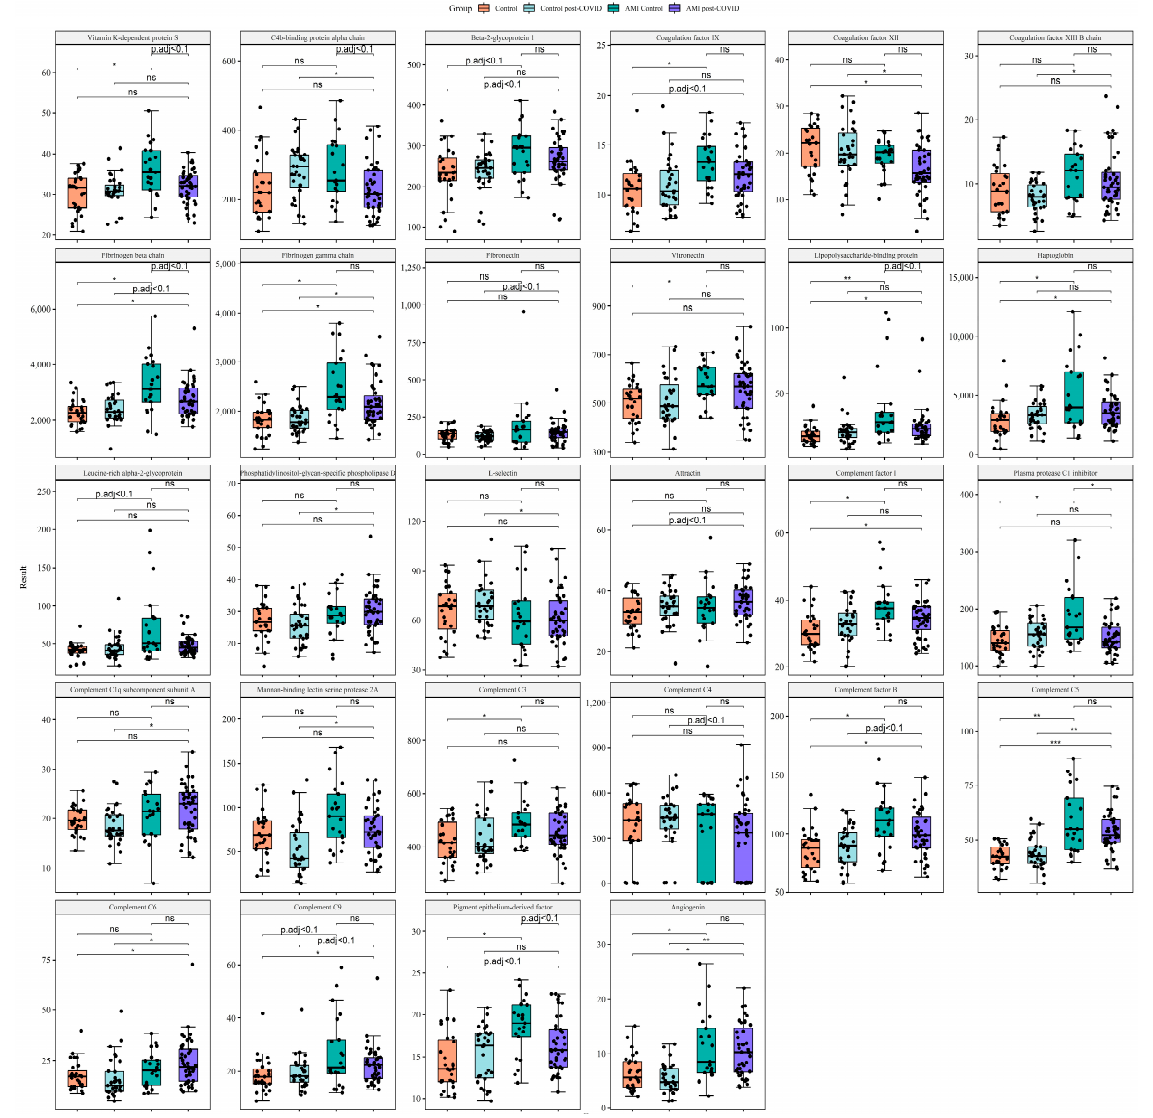
Figure 1. Main comparisons of proteomics data between study groups. Targeted proteomic analysis was carried out using liquid chromatography–tandem mass spectrometry (LC-MS/MS) with multiple-reaction monitoring (MRM). For comparison of several groups, we used the Mann–Whitney rank test with a continuity correction. In order to overcome errors from multiple comparisons, we performed a Benjamini–Hochberg FDR correction, with calculation of critical values for each comparison matched with corresponding p -values; we calculated adjusted p -values and compared them with a critical value of 0.1 to keep the positive false discovery rate below 10%. Data are presented as the median [Q1; Q3]. * p adj. < 0.05, ** p adj. < 0.01, *** p adj. < 0.001, ns, not significant. The boxplots include proteins different between the AMI control and AMI post-COVID groups: C4b-binding protein alpha-chain, fibrinogen beta-chain, lipopolysaccharide-binding protein, PEDF, plasma protease C1 inhibitor, vitamin-K-dependent protein S. Based on their function, we focused on proteins connected to hemostasis, acute-phase proteins, and components of the complement system. Intheboxplots,weincludedproteinswiththesefunctionsiftheyweredifferentinatleastoneofthecomparisons: AMI control vs. control, AMI post-COVID vs. control, AMI post-COVID vs. control